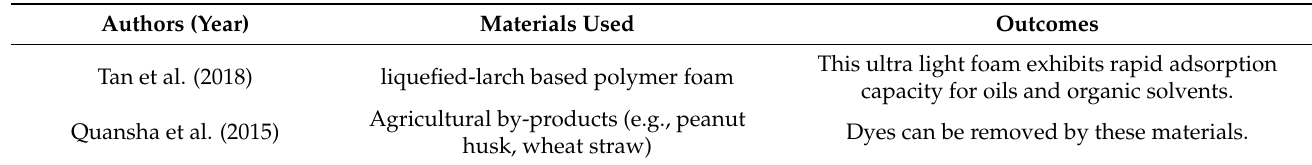
Table 3. Recent studies of biomass for removal of oils and dyes from wastewater.